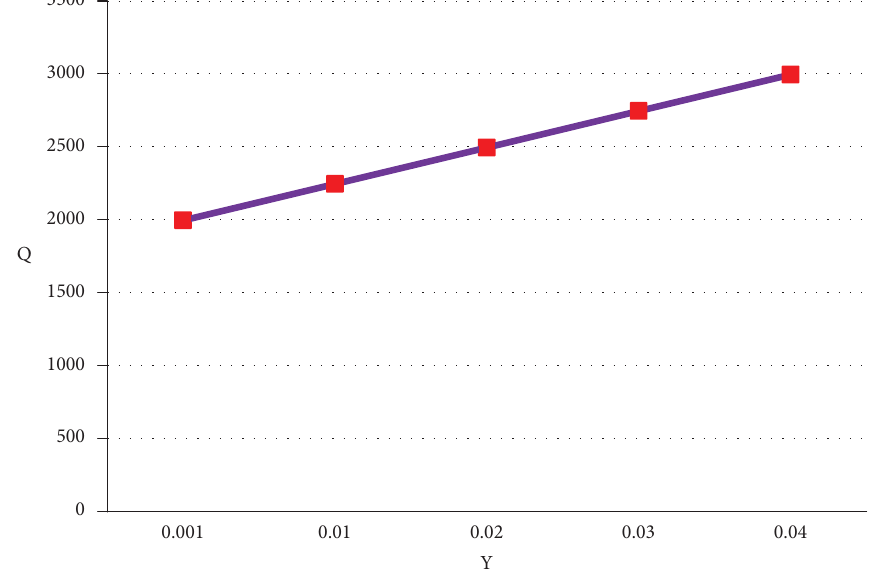
Figure 5: Te efect of parameter Y on the amount of economic production